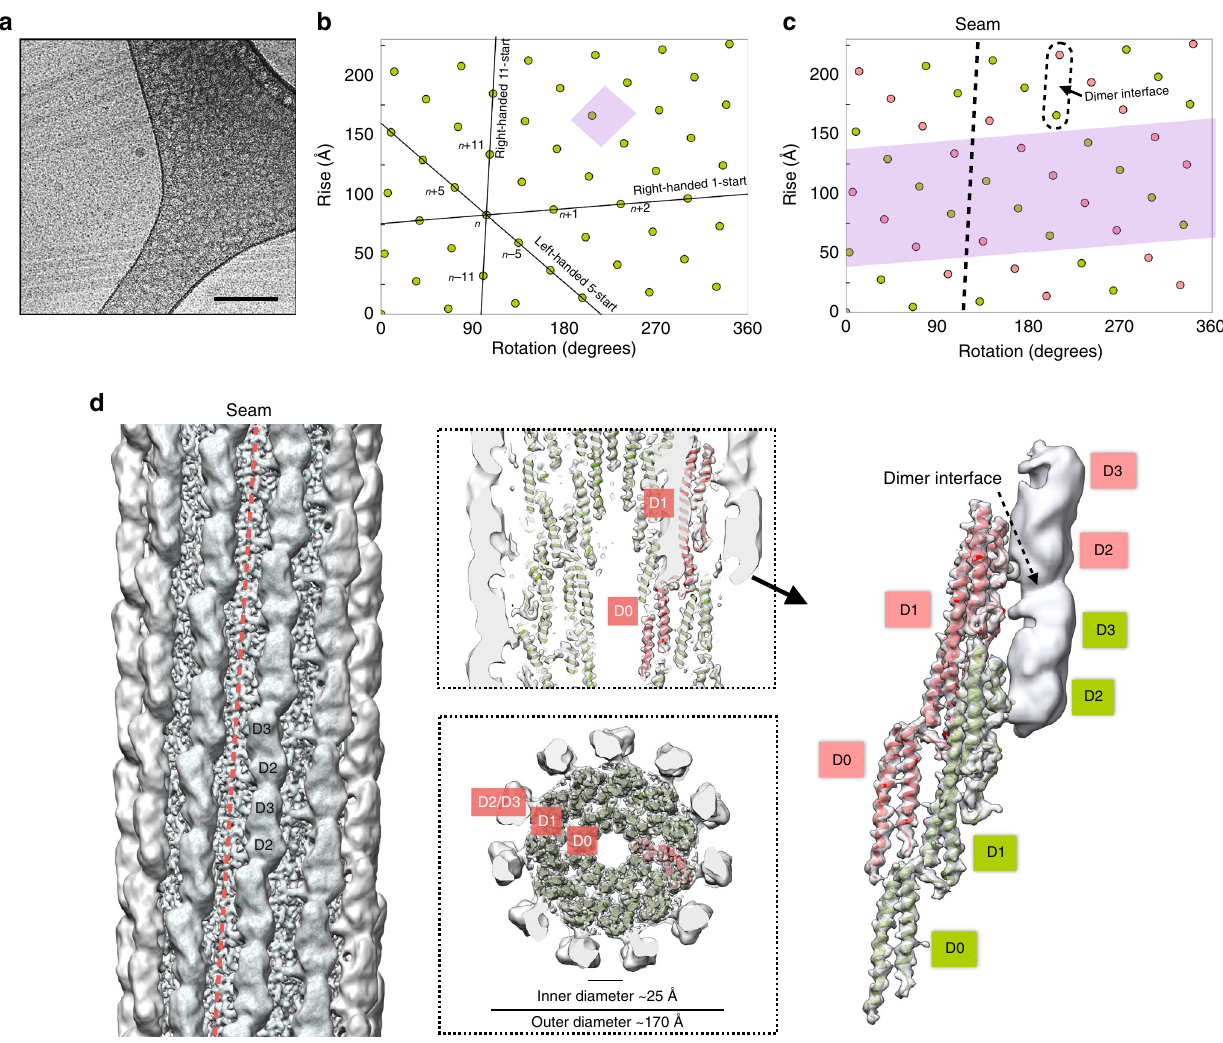
Fig. 2 Cryo-EM reconstruction and fl agellar fi lament model of P. aeruginosa . a Cryo-electron micrograph of P. aeruginosa fl agellar fi lament. The scale bar represents 100 nm. b The helical net of R-type fl agellar fi lament core (D0 and D1 domain) of P. aeruginosa . c The helical net of D2/D3 domain in the R-type fl agellar fi lament of P. aeruginosa . d The side view, the central slice through the lumen, the top view and the segmented dimer view of the cryo-EM reconstructions of the R-type fl agellar fi lament A443V of P.